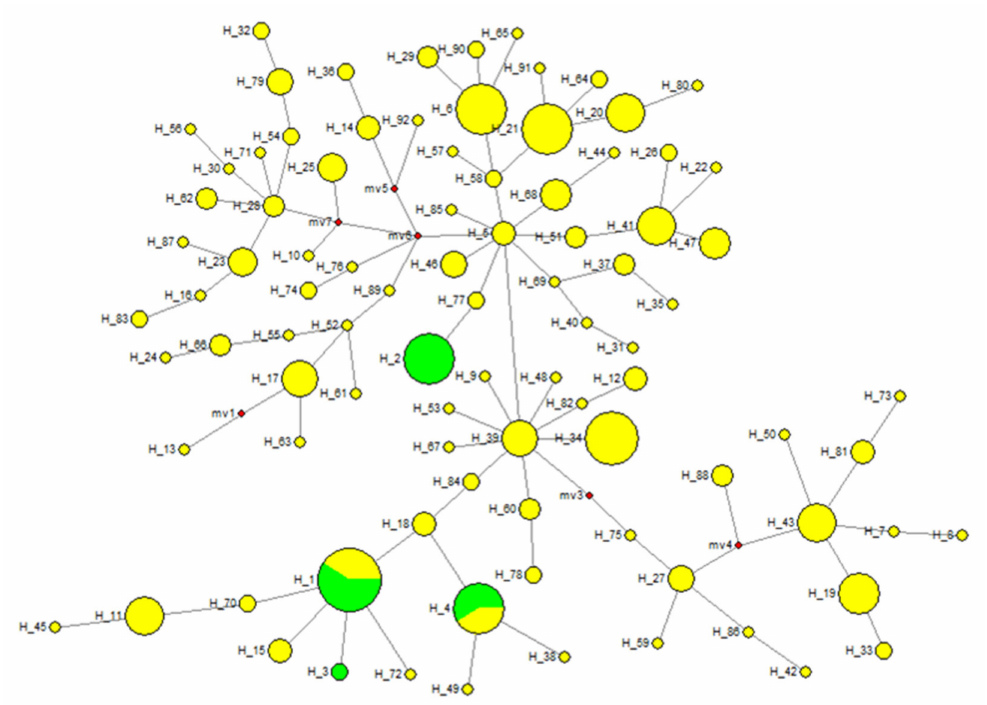
Figure 5. Median-Joining network reconstructed from 92 combined Ethiopian and Eurasian type Turkish Anatolian horse haplotypes (Ethiopian haplotypes = green; Turkish Anatolian haplotypes = yellow). Circles are proportional to the frequency of individual